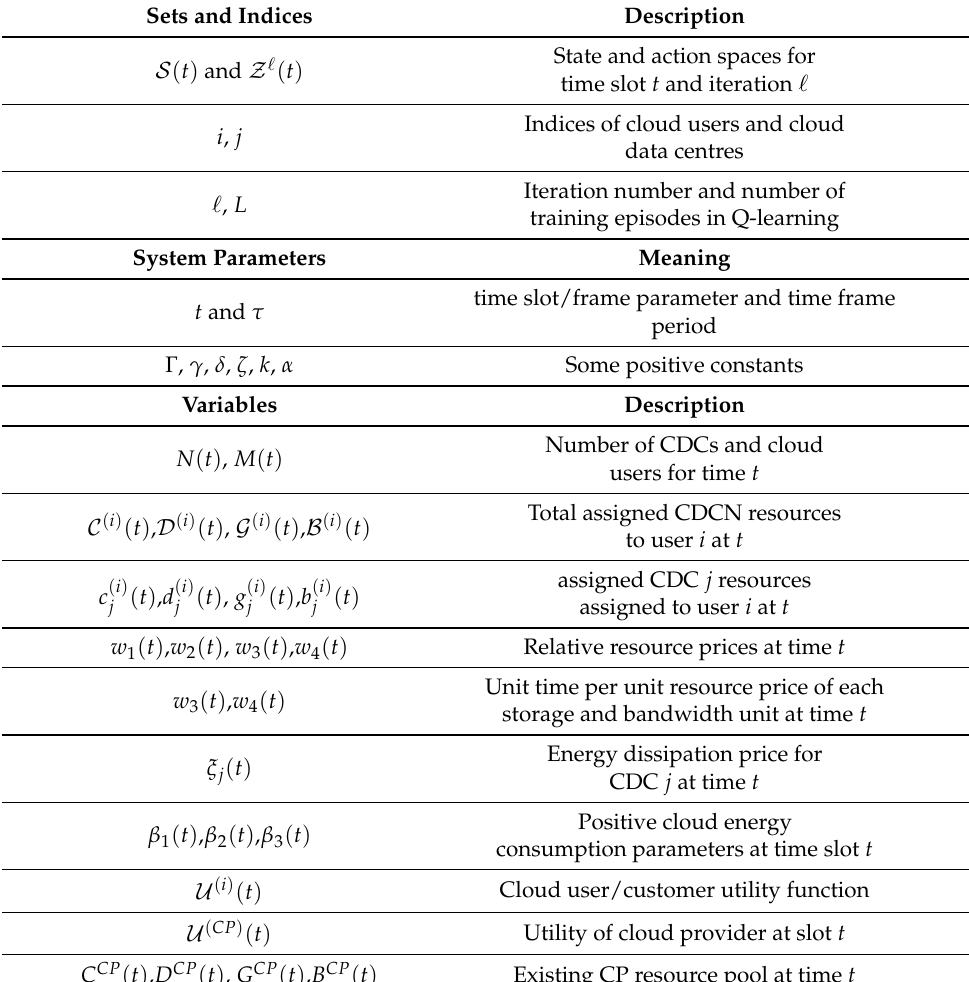
Table 2. System parameters. Sets and